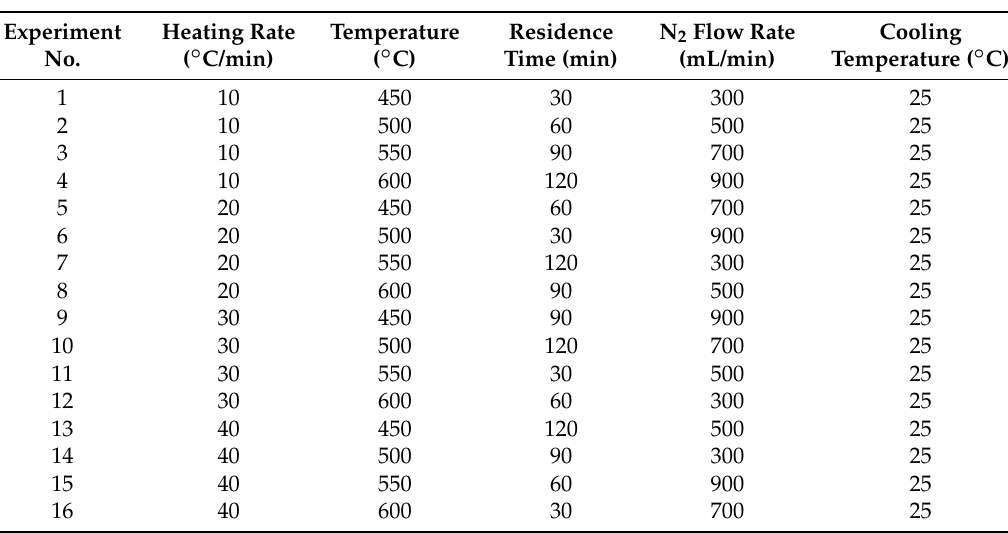
Table 3. Experimental layout using an L 16 (4 5 ) orthogonal array.